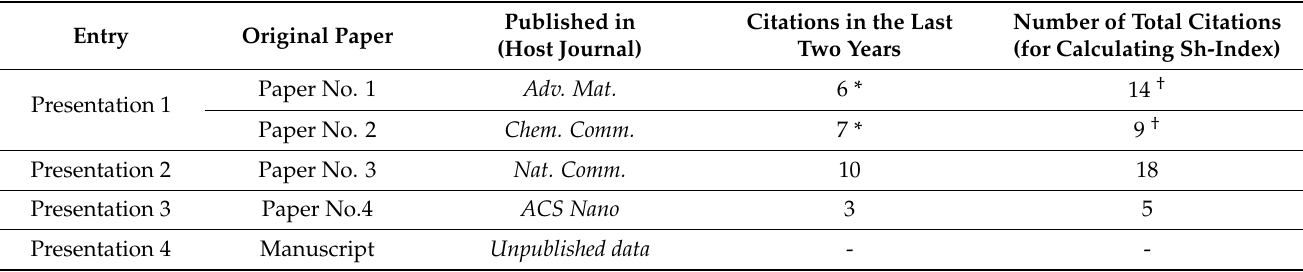
Table 1. List of 3 presentations that come from 4 previously published papers to be introduced at a